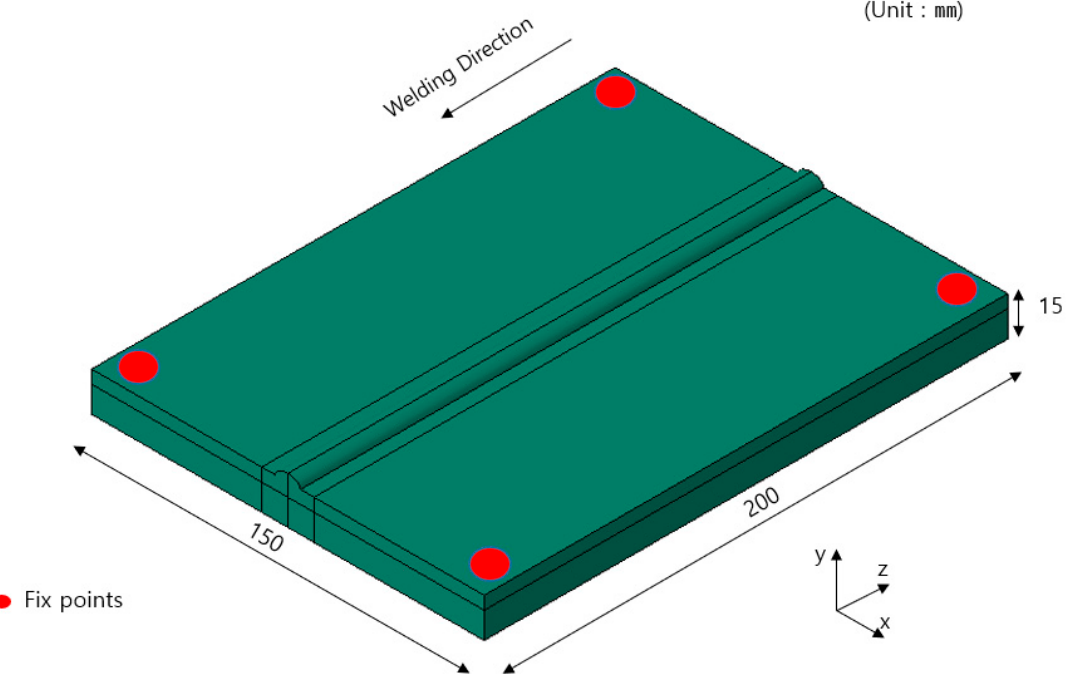
Figure 2. Schematic diagram of welding.